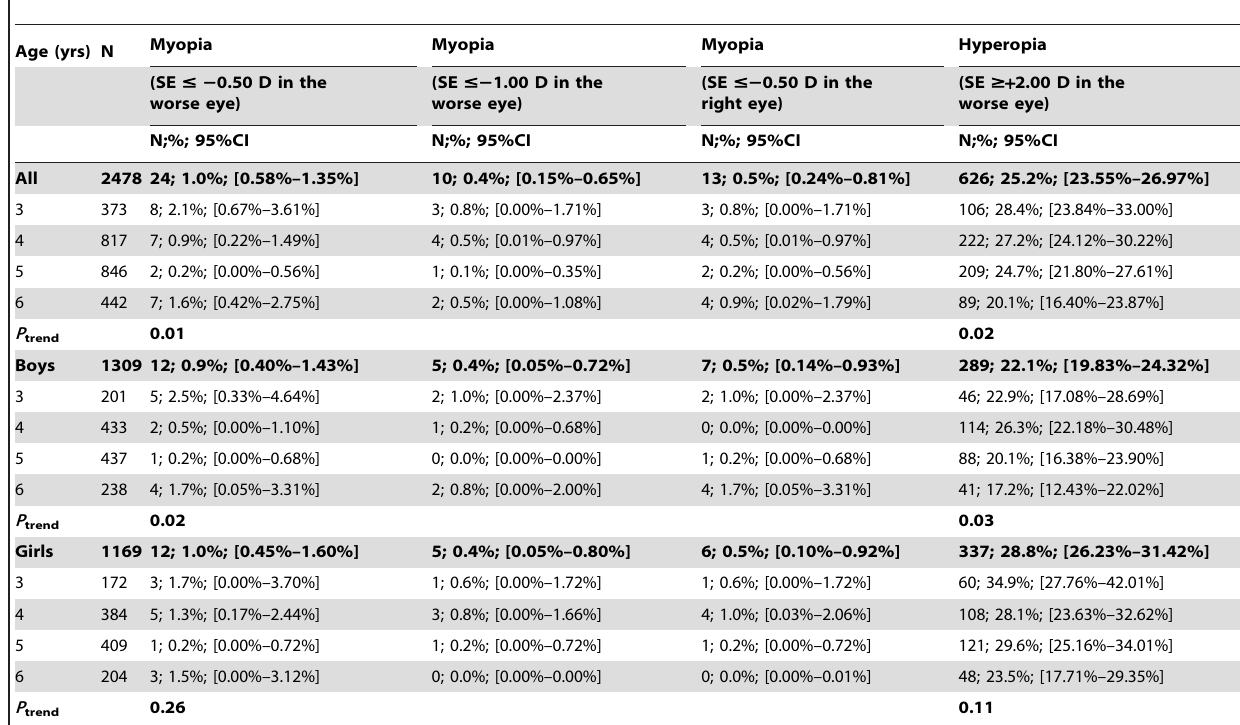
Table 3. Prevalence of Myopia and Hyperopia in 3–6 year-old Chinese Children Determined by Autorefraction.